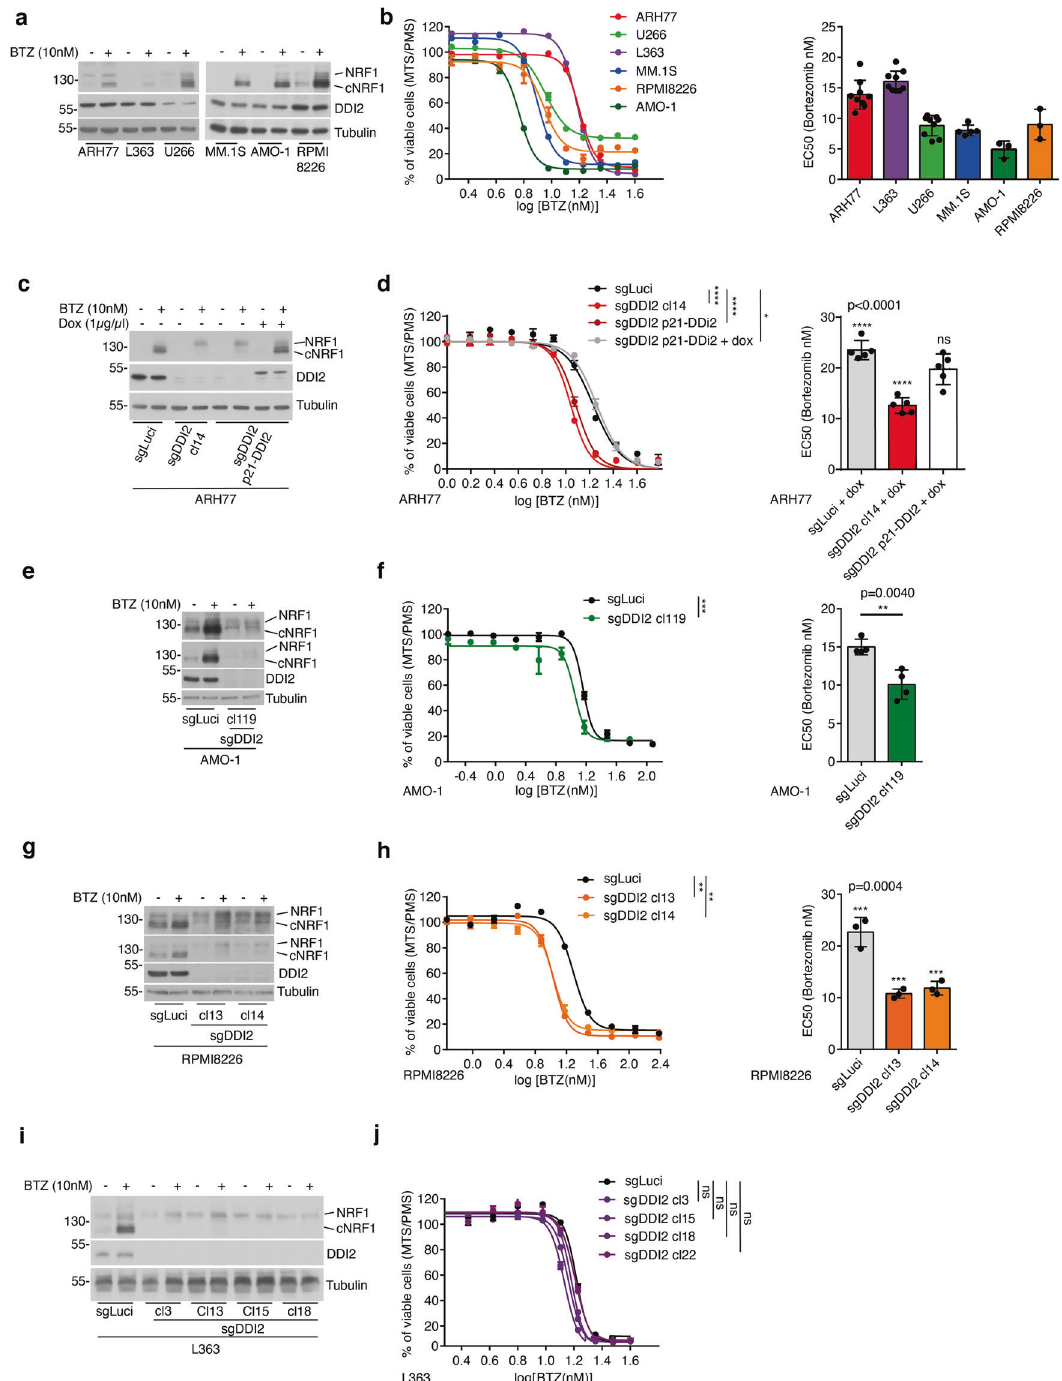
Fig. 2 DDI2 de fi ciency affects Bortezomib sensitivity of sensitive and resistant Myeloma cells. a , b Indicated multiple myeloma cell lines were treated with BTZ or vehicle and analyzed by immunoblot for protein expression of DDI2 and NRF1, cNRF1, indicates cleaved NRF1. Tubulin is used as a loading control ( a ). Viability assay was assessed by MTS/PMS assay. Dots graph represents the EC50 (half-maximal effective concentration) of the dose responses ( b ). c , d A representative ARH77 clone expressing DDI2 sgRNA and de fi cient for DDI2 expression was reconstituted with an inducible N-ter FLAG-DDI2 construct (backbone PINDUCER21) and treated with BTZ and doxycycline (Dox) as indicated. The expression of DDI2, NRF1, and cNRF1 was monitored by immunoblotting ( c ). Viability assay of control cells and reconstituted cells treated with BTZ or Dox was performed as indicated ( d ). e – j AMO-1, RPMI8226, and L363 populations expressing control luciferase (Luci) sgRNA or representative clonal DDI2-de fi cient populations were treated with BTZ or vehicle as indicated and analyzed by immunoblotting for expression of DDI2, NRF1, and cNRF1 ( e , g , i ). Sensitivity to BTZ of control cells and representative DDI2-de fi cient clones were analyzed by viability assay ( f , h , j ). Curve graphs are from one representative experiment of two or three replicates. P -values were calculated using two-way ANOVA between control cells and KO cells. Dots graph represents the EC50 (half-maximal effective concentration) of the dose responses; data are from at least three independent experiments performed in triplicate. P -values were calculated using one-way ANOVA followed by Dunnett ’ s multiple comparison tests ( d , h ) or using two-tailed unpaired Student ’ s t -tests ( f ). Cell Death and Disease (2022)